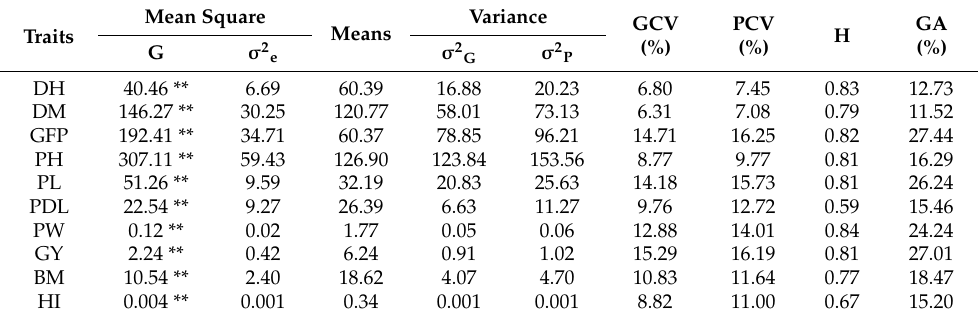
Table 3. Mean squares, variance components, and estimates of variability for important traits of 317 teff genotypes under the intensive growing